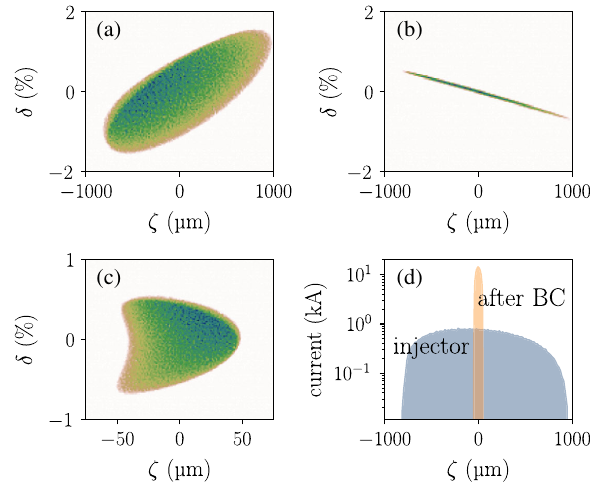
FIG. 9. Snapshots of the LPS distributions at the exit of the photoinjector (a), after acceleration to 5 GeV (b) and downstream of a single-stage bunch compressor (c) and current distribution (d) at the injector exit ( “ injector ” ) and downstream of the bunch compressor ( “ after BC ”